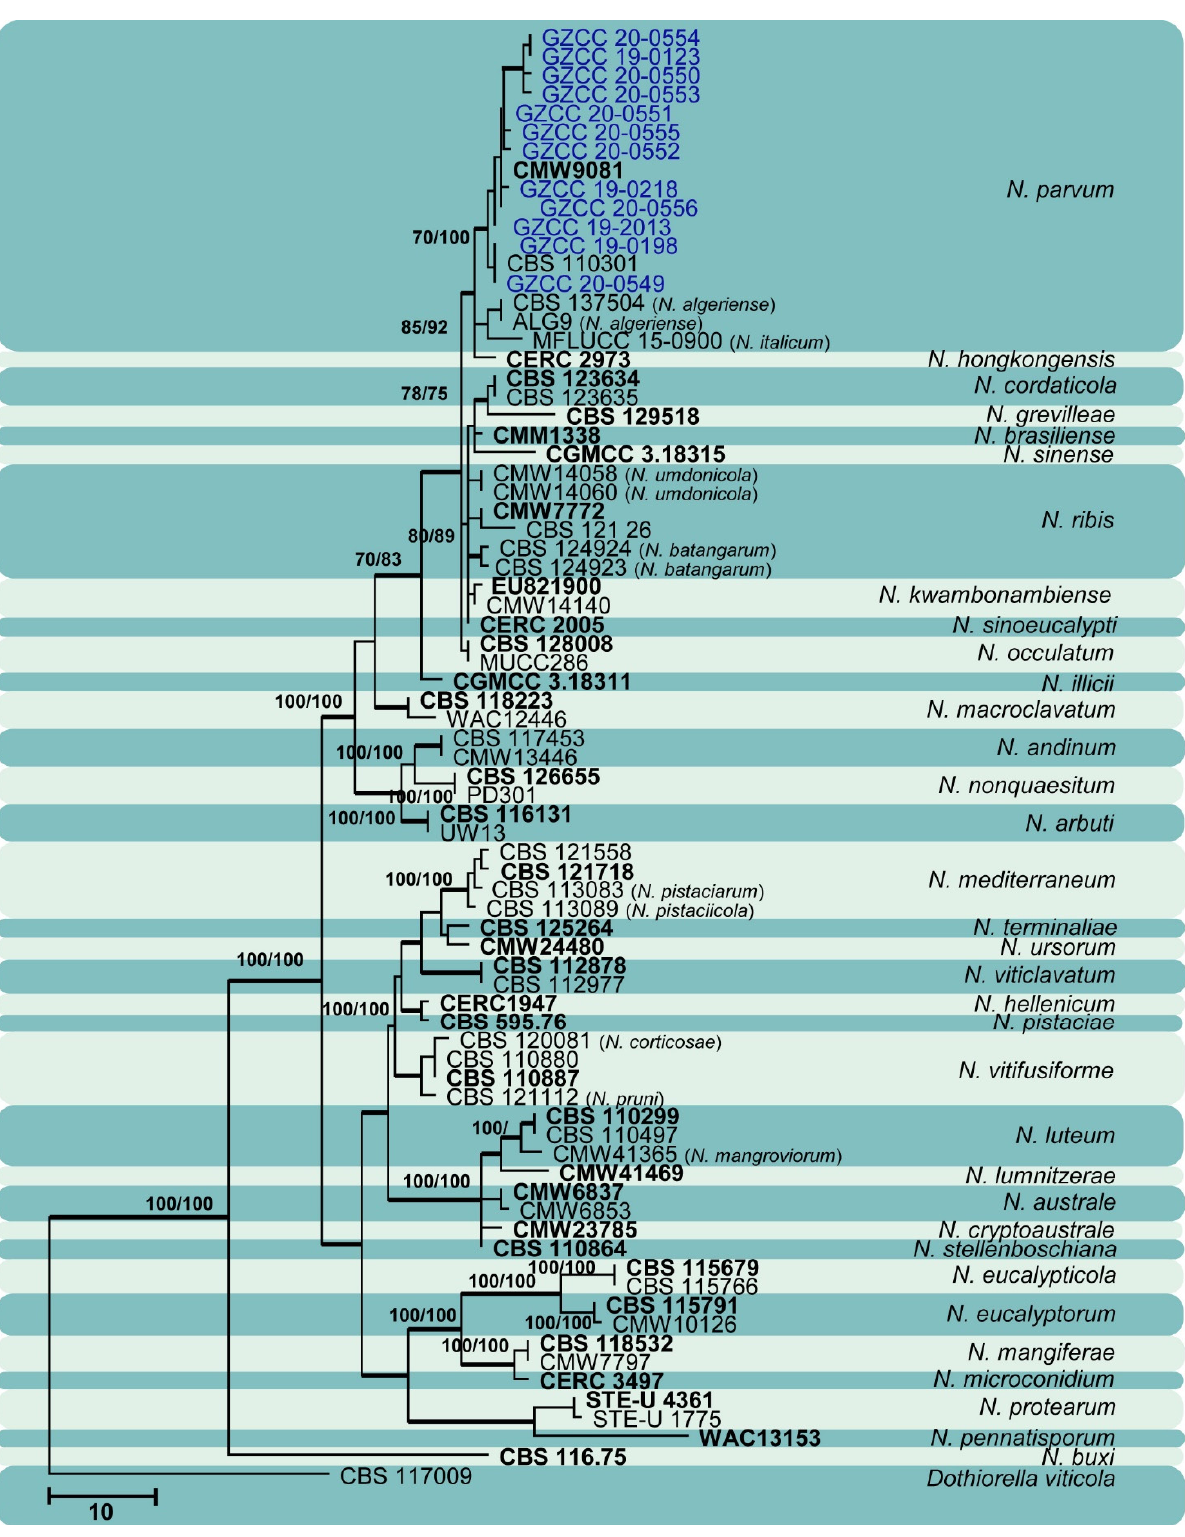
Figure 14. Maximum likelihood tree based on analysis of combined ITS and tef sequences of Neofusicoccum . Bootstrap support values of ML, MP > 75% are shown near the nodes, and branches in bold indicate BI probabilities >0.95. Isolates obtained in this study are in blue for known species. Ex-type strains are in bold. The tree is rooted to Dothiorella viticola (CBS 117009).